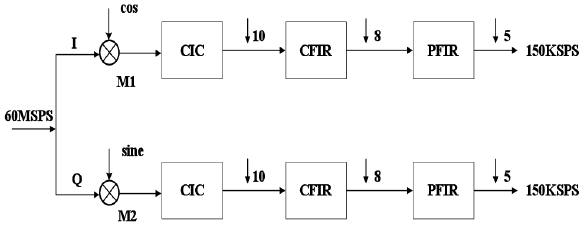
Figure 3. Block diagram of DDC in Receiving